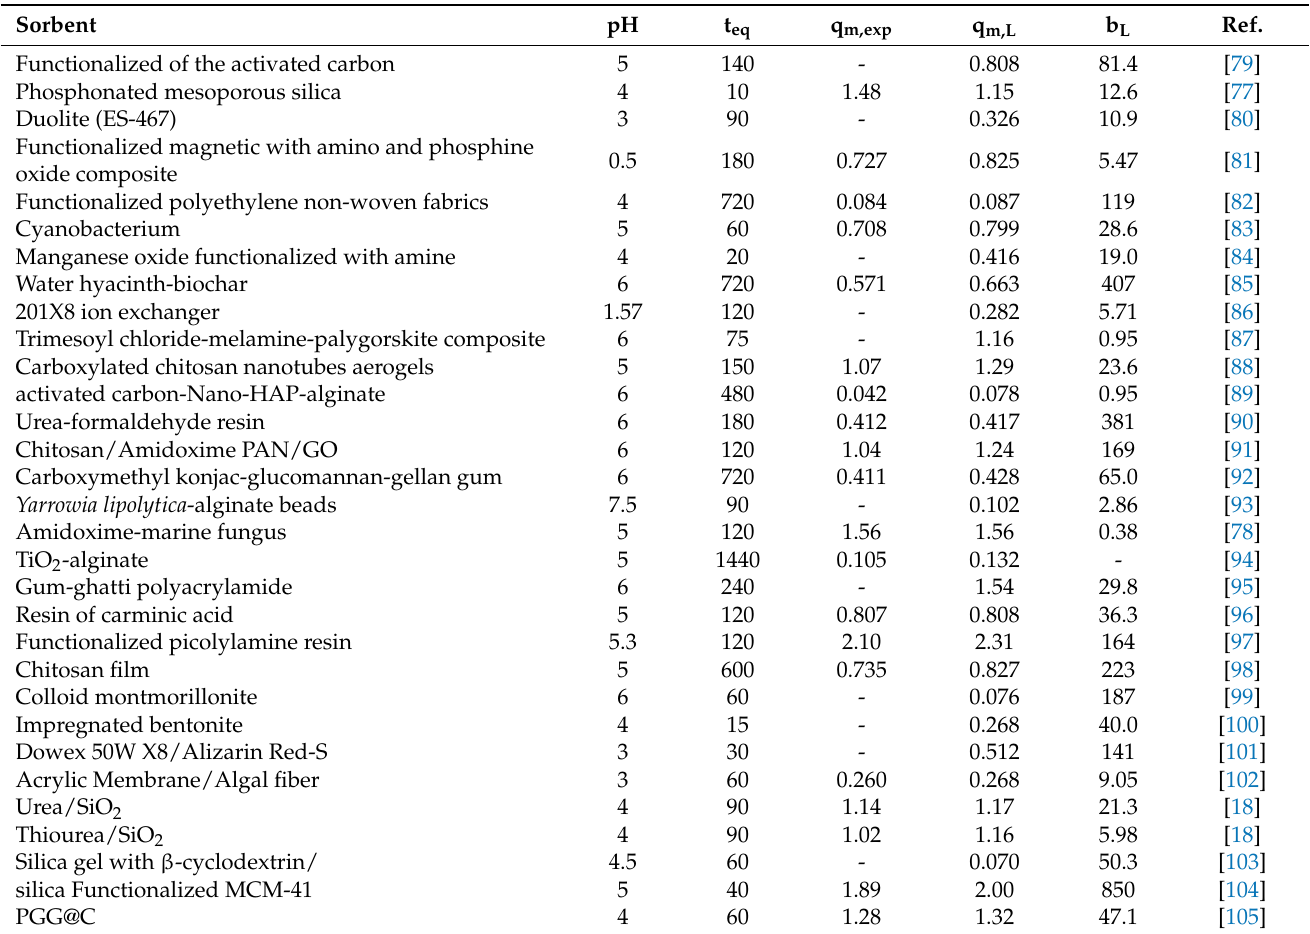
Table 6. U(VI) sorption properties of alternative